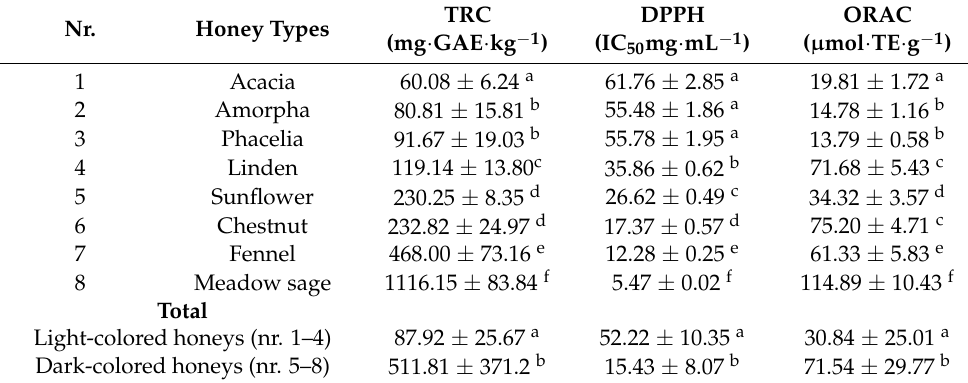
Table 2. Total antioxidant capacities of selected honey samples.